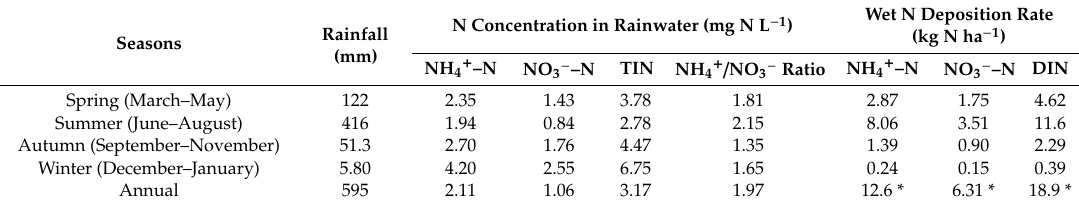
Figure 1. Monthly patterns of ( a ) precipitation amounts and VWM concentrations (mg N L − 1 ) of inorganic nitrogen species (i.e., NH 4 + –N and NO 3 − –N); ( b ) proportion of NH 4 + –N and NO 3 − –N to TIN in wet deposition at the Daheitin (DHT) reservoir, a rural site in North China from July 2019 to June 2020. There was no precipitation during December 2019 and January 2020. Table 2. Annual and seasonal variations in rainfall (mm), NH 4 + –N / NO 3 − –N ratios, annual VWM concentrations (mg N L − 1 ) of inorganic nitrogen (NH 4 + –N, NO 3 − –N, and TIN), and wet N deposition rates (kg N ha − 1 ) at the DHT reservoir, a rural site in North China from July 2019 to June 2020. Seasons Rainfall